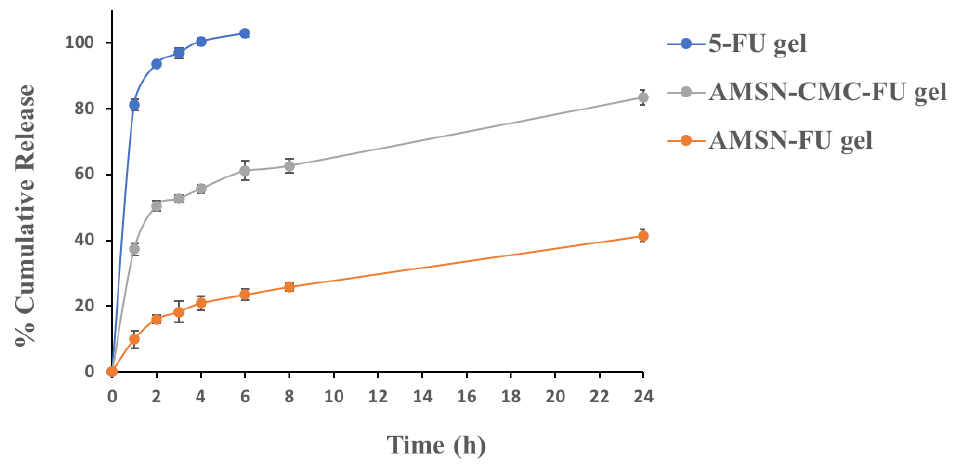
Figure 8. In vitro release of 5-FU gel, AMSN-FU gel, and AMSN-CMC-FU gel. The values are represented as the mean of three measurements with standard deviation (Mean ± SD, n = 3).